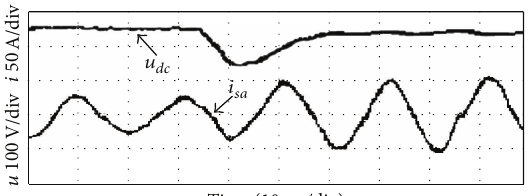
Figure 12: Waves of DC bus voltage and power grid current (load changes).